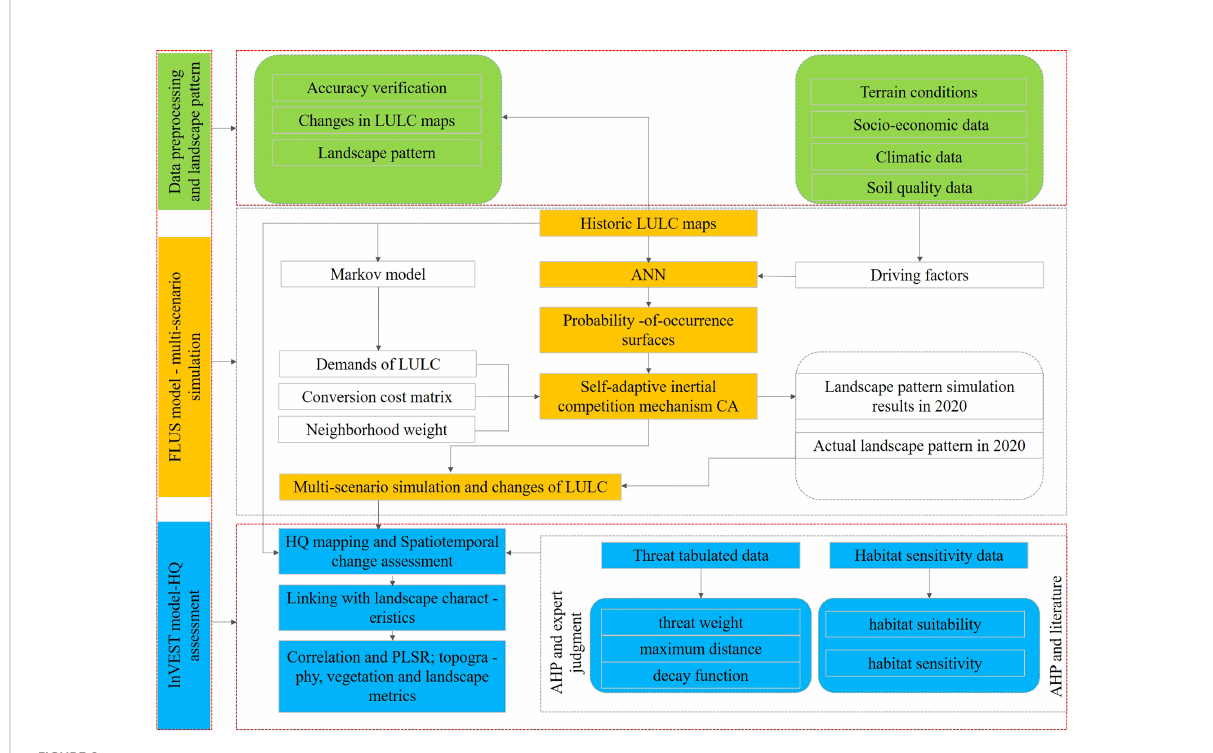
FIGURE 2 The research fl ow